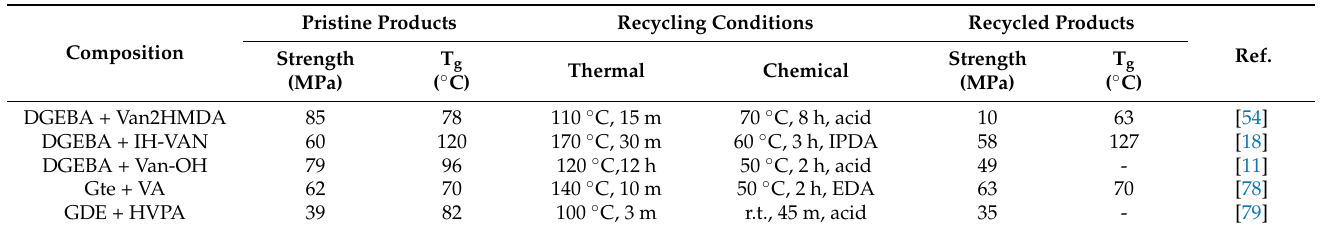
Figure 11. Possible formation of recyclable curing agents from biobased vanillin. Table 3. Thermal and mechanical properties, as well as recycling conditions of vanillin-modified curing agents cured